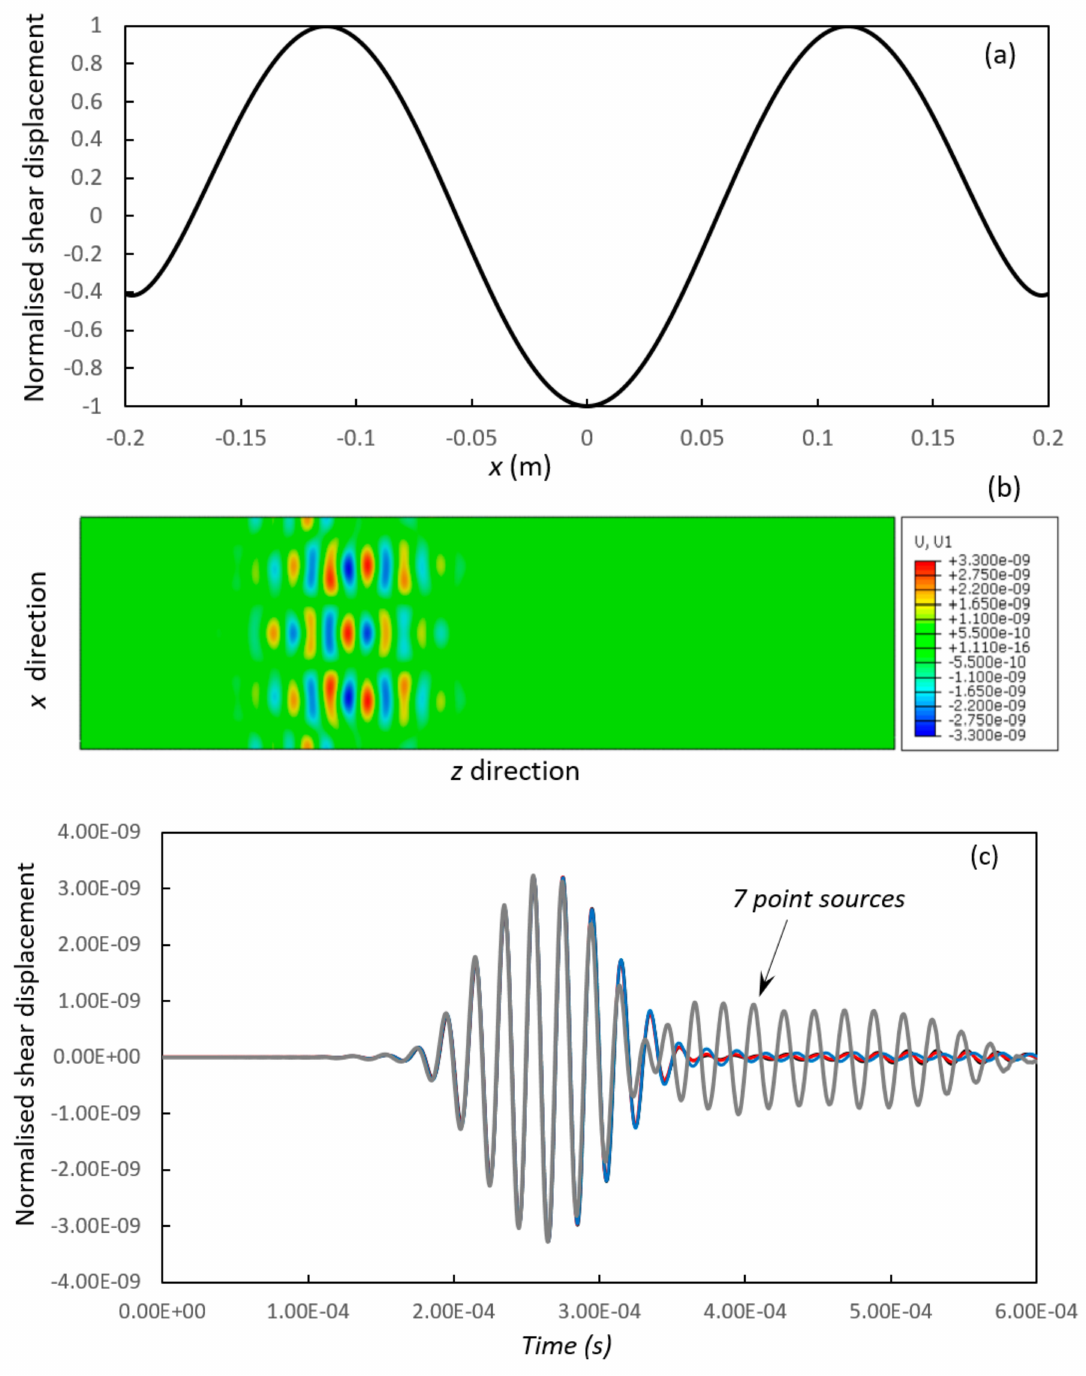
Figure 9. Excitation of shear-type mode A1*: ( a ) shear displacement loading; ( b ) generated shear displacement distribution (top view); ( c ) time domain displacement at receiver position. , 19 point sources; , 15 point sources; , 9 point sources; , 7 point